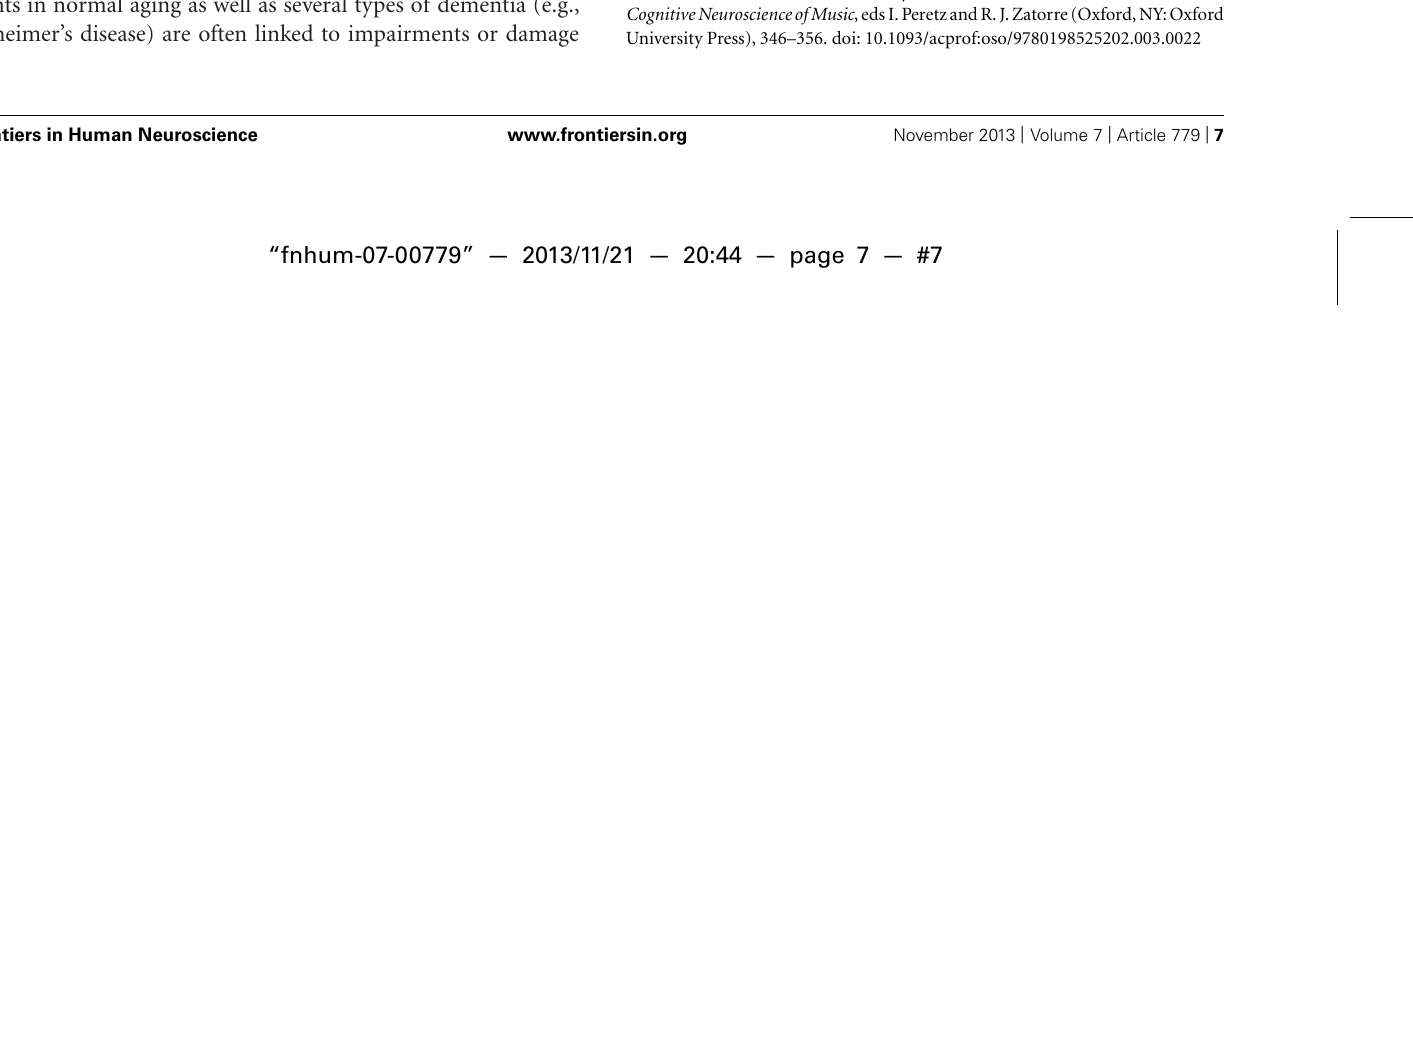
(channels 1, 2, 3, and 4, corresponding to EEG channelsAF8, F6, F4,AF4) hemisphere during memory encoding for the silence (solid lines) and music (dotted lines)